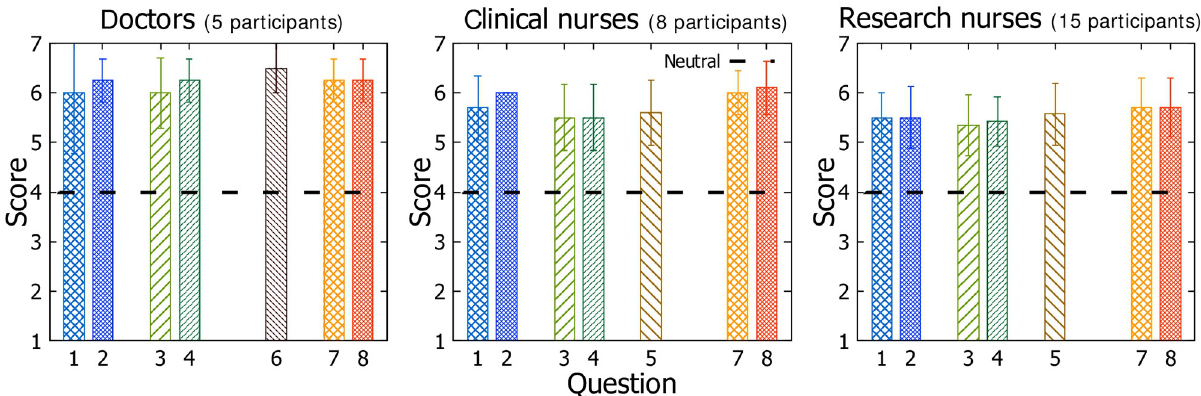
Fig 7. Scores for the multiple choice questions in the post survey with 5 doctors, 8 clinical nurses and 15 research nurses. Score 4 represents “neutral” in a 7 point Likert-scale.